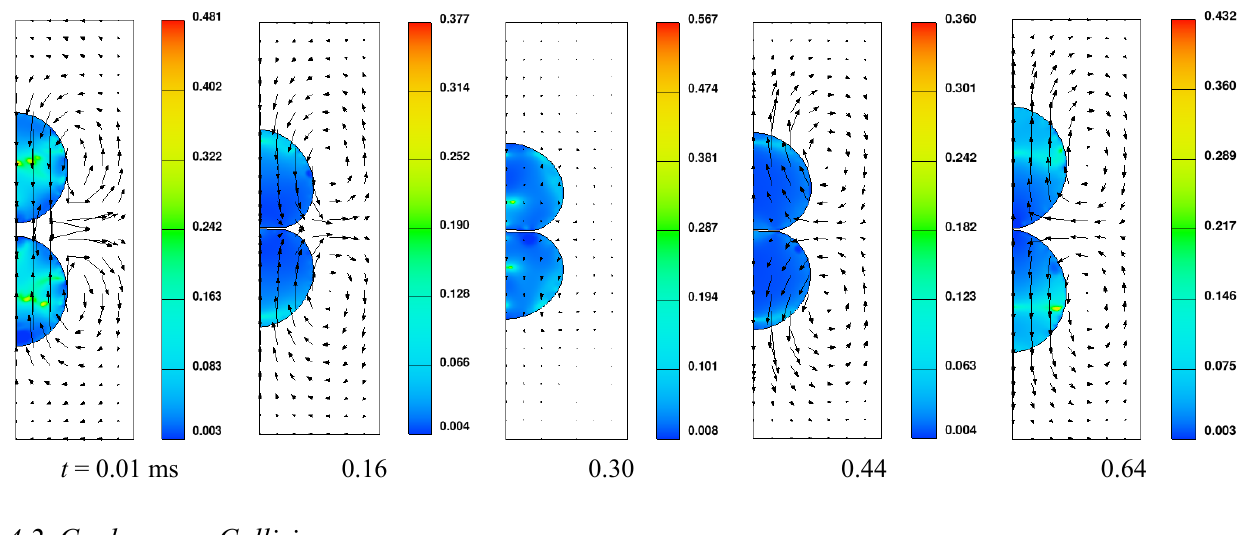
Figure 7. Dynamic viscosity (Pa·s) and velocity field evolution for bouncing collision.